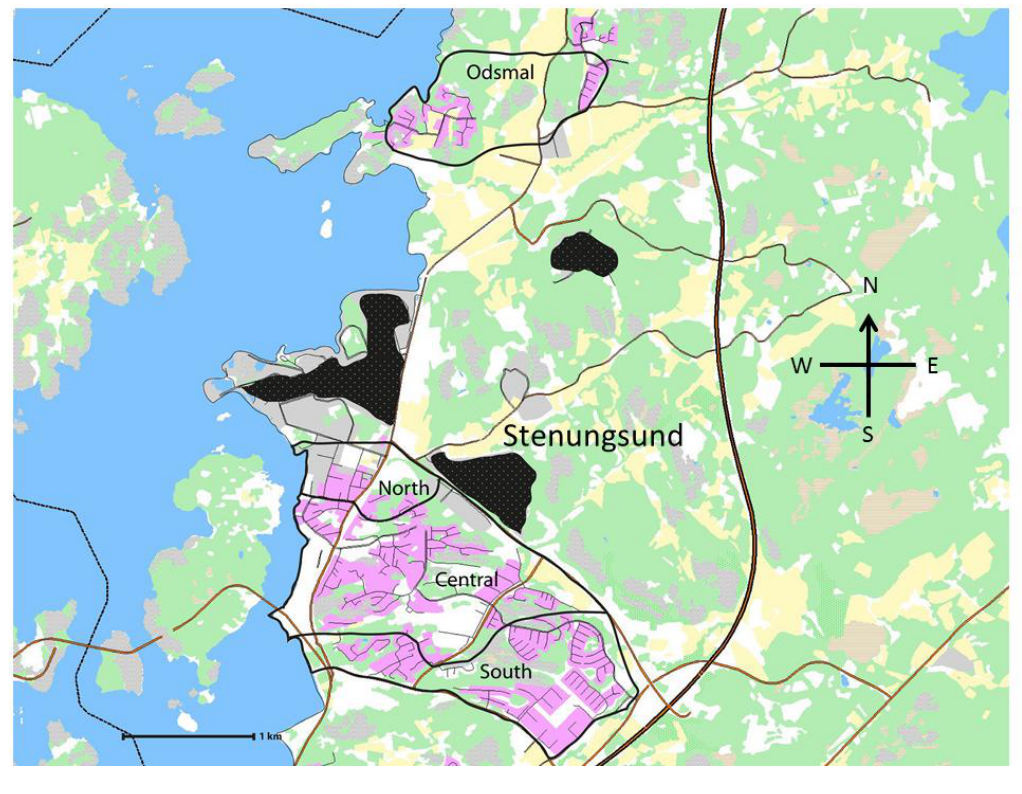
Figure 1. “Exposed areas”: three areas (North, Central, and South) in the municipality of Stenungsund and the municipality of Odsmal, 3 km north of Stenungsund in the direction of the prevailing winds from the industrial sites. The black areas represent the location of the petrochemical plants. Residential areas are marked with pink